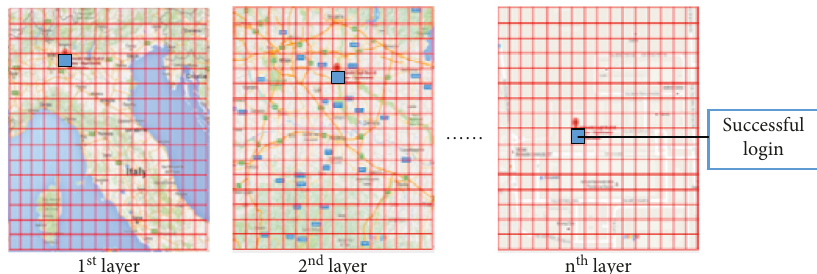
Figure 3: The login process by selecting a grid on each layer of Google Map in the GMGP system